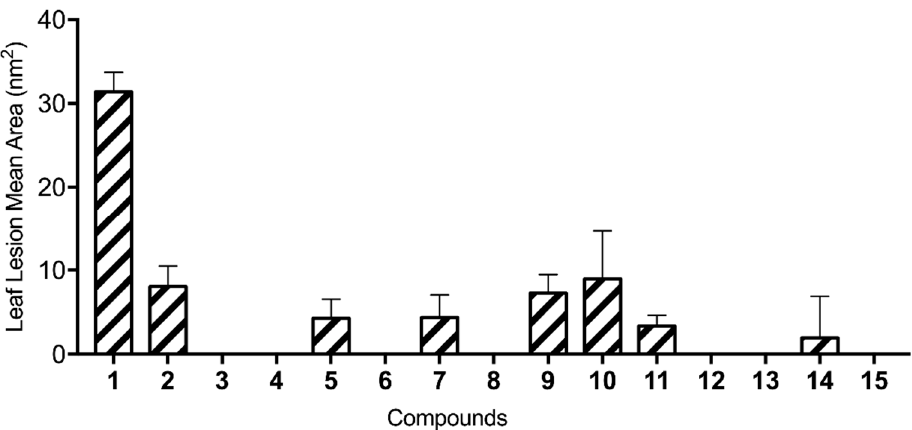
Figure 2. Results of the leaf puncture bioassay on buffelgrass ( Cenchrus ciliaris ) at a concentration of 2.5 × 10 − 3 M for the hemisynthetic derivatives ( 6 – 15 ) and the natural compounds ( 1 – 5 ).